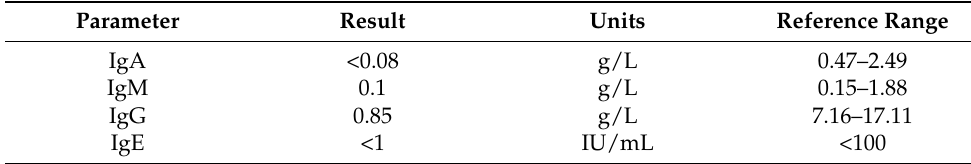
Table 2. Serum immunoglobulin